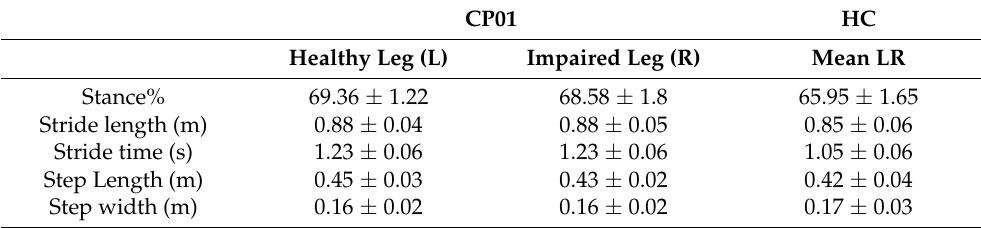
Table 4. Spatiotemporal parameters. For CP01, both healthy and paretic legs are shown. For HC, the mean value between legs is reported. Mean and standard deviation values are computed over the total number of steps. L: left; R right.